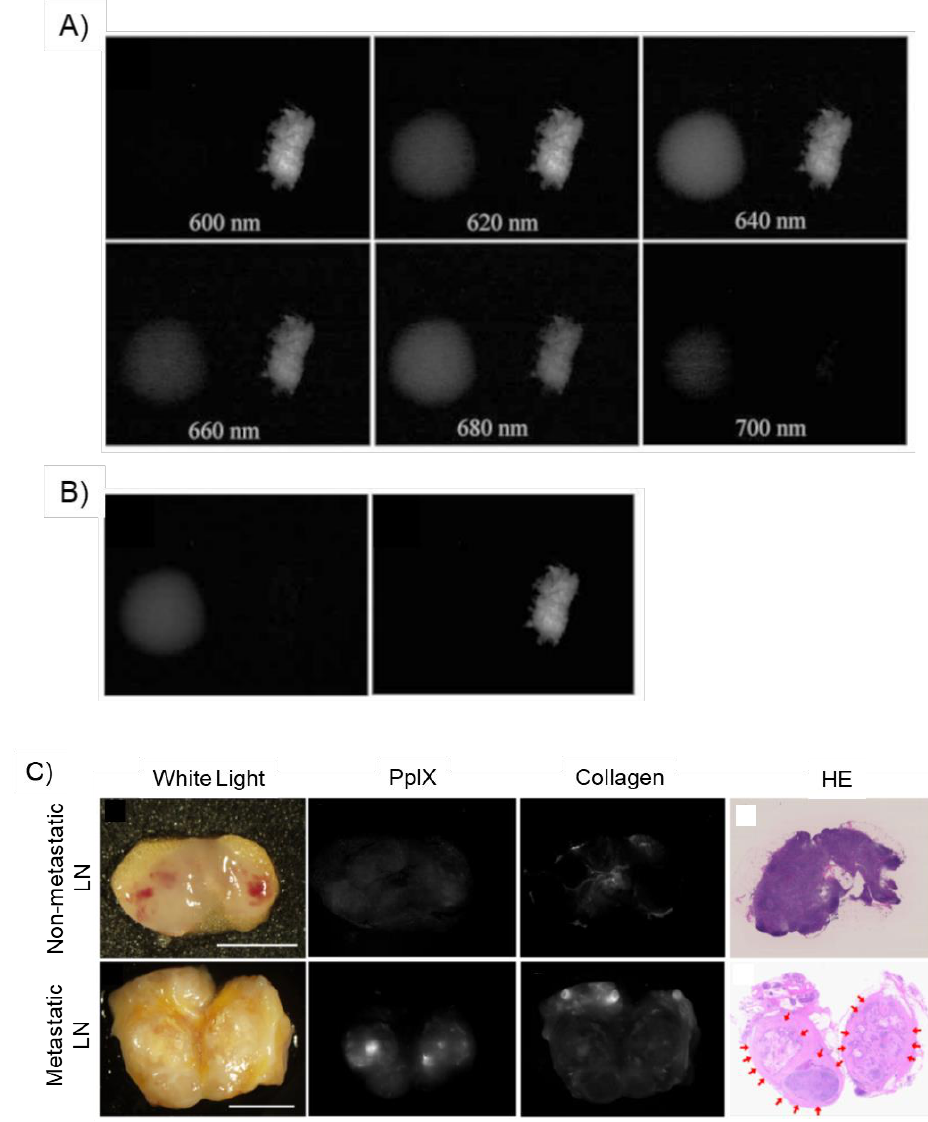
Figure 4. Elimination of background tissue autofluorescence by using a spectral unmixing method for specific visualization of protoporphyrin IX (PpIX) fluorescence. “Reprinted/adapted with permission from Ref. [14]. 2021, MDPI”. Results of imaging of lymph node (LN) metastases in human bowel carcinoma are shown. ( A ) Hyperspectral fluorescence images of pure chemicals of PpIX (left part in each image) and collagen (right part in each image) as references for calculating spectral unmixing. The fluorescence images obtained from 600 to 700 nm at 20-nm intervals are shown. ( B ) Obtained graphics of PpIX (left image) and collagen (right image) after spectral unmixing on the basis of the reference spectral images ( A ). ( C ) Representative images of LNs cut in half: non-metastatic (upper images) and metastatic LNs (lower images) are shown. White-light images (1st row), spectral unmixed fluorescent images of PpIX (2nd row), spectral unmixed fluorescent images of collagen (3rd row), and hematoxylin – eosin-stained images (4th row). Red arrows show metastatic carcinomatous regions. 5-ALA hydrochloride (15 mg/kg of body weight) was administered orally two hours before surgery. Scale bar: 5 mm.